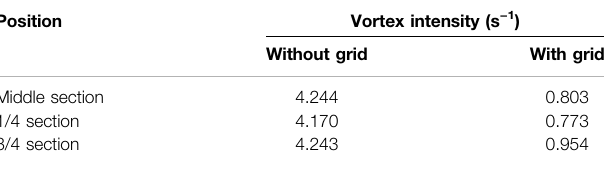
TABLE 1 | Average vortex intensity in the straight section of the cold fl uid